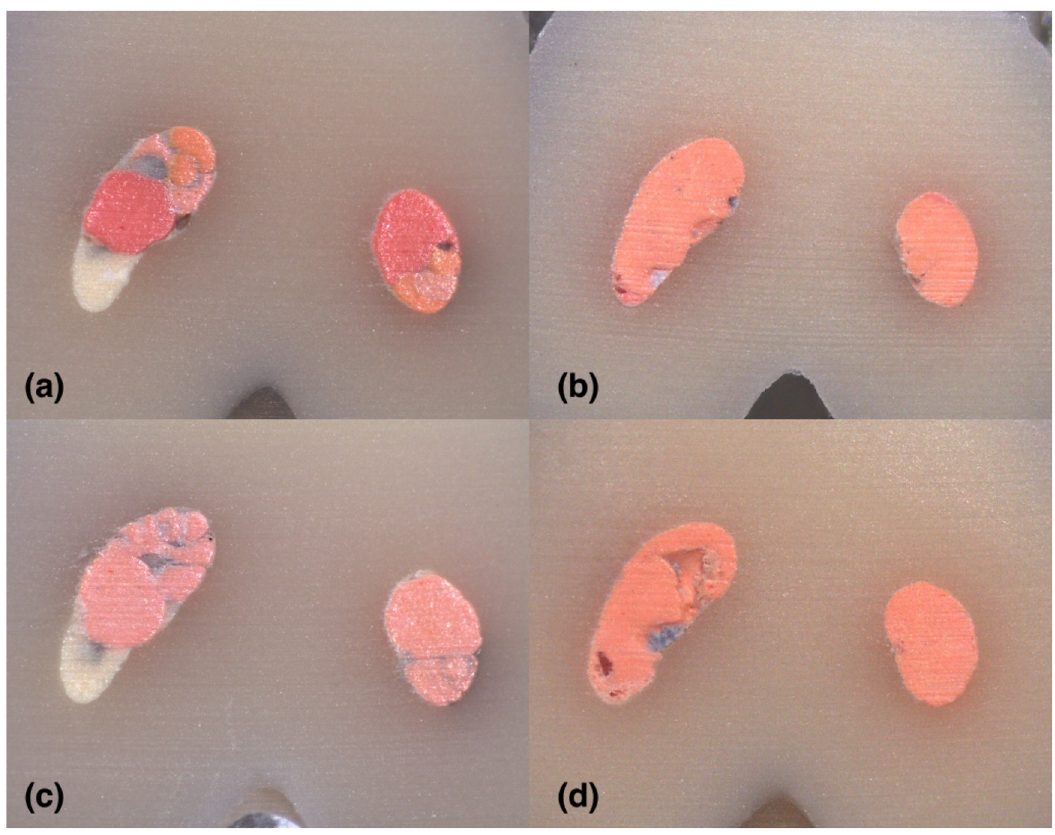
Fig 11. Stereomicroscope images of 6 mm sections instrumented with Hyflex EDM: (A) LC (B) CW; Stereomicroscope images of 6 mm sections instrumented with Reciproc Blue: (C) LC (D) CW in C2-type.